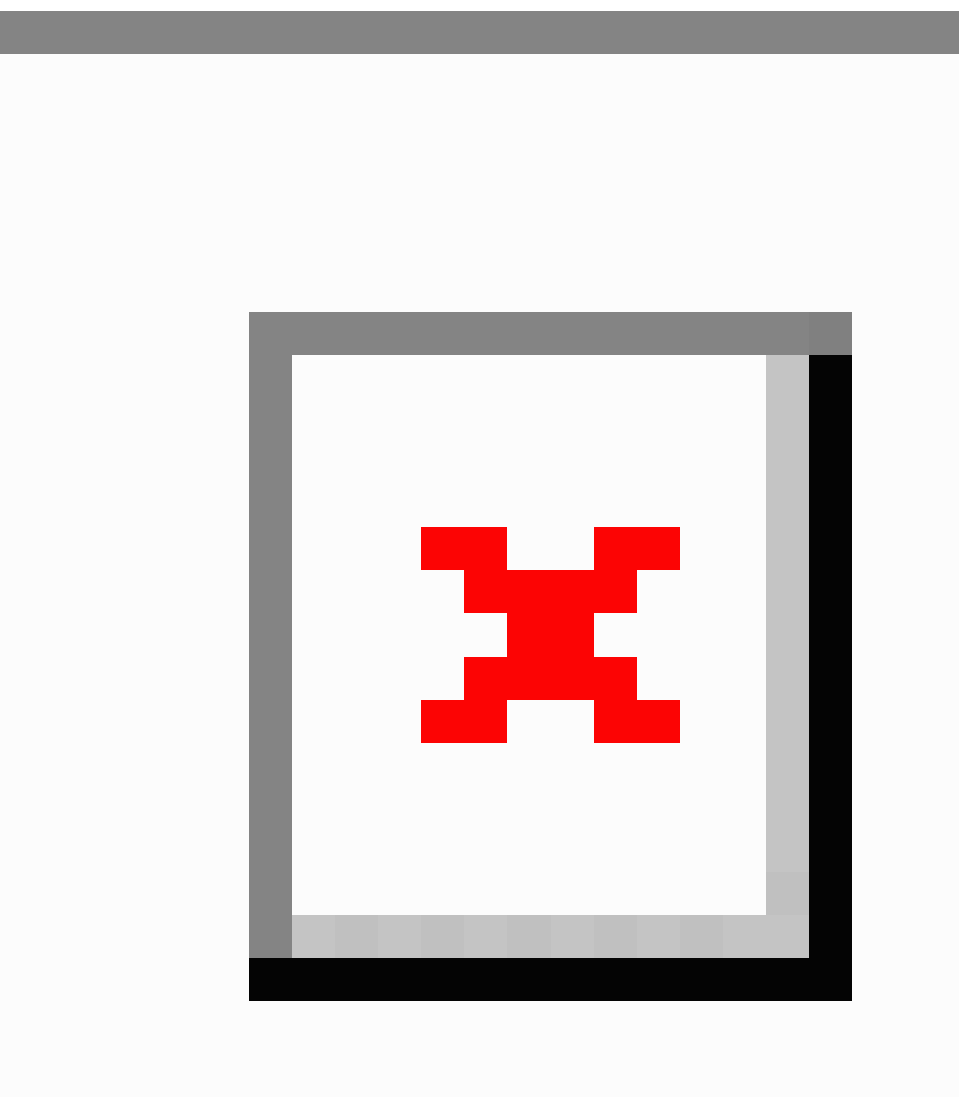
Figure 6. Left: Each helper T lymphocyte (Th cell) is equipped with an intra-cellular dynamics consisting of a gene regulatory network to describe the dynamical rule for the differentiation from Th0 to Th1/Th2 phenotype. Right: The regulatory network dynamics is a function of the cytokine environment